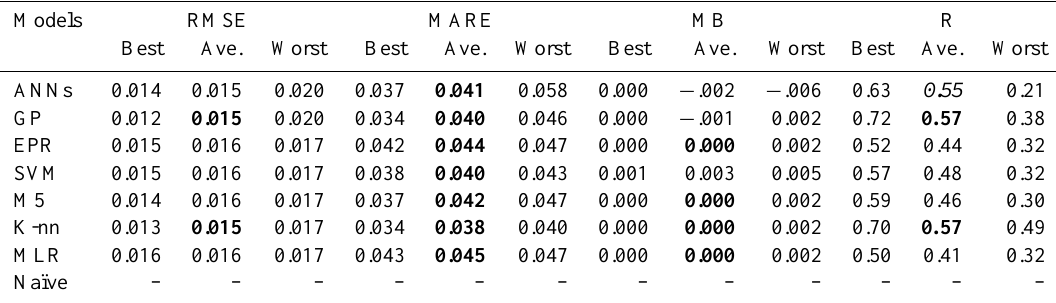
Table 12. Testing results of all models applied to the Till moisture dataset. Models